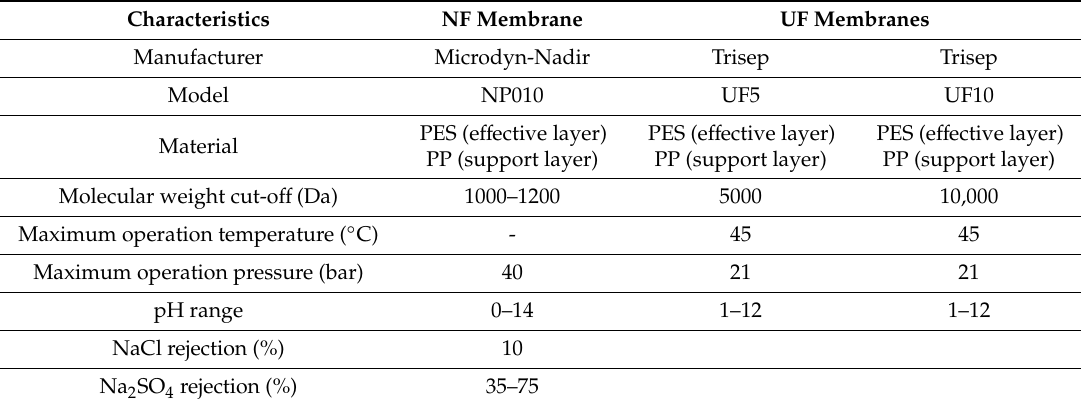
Table 1. Characteristics of the NF and UF membranes used in this